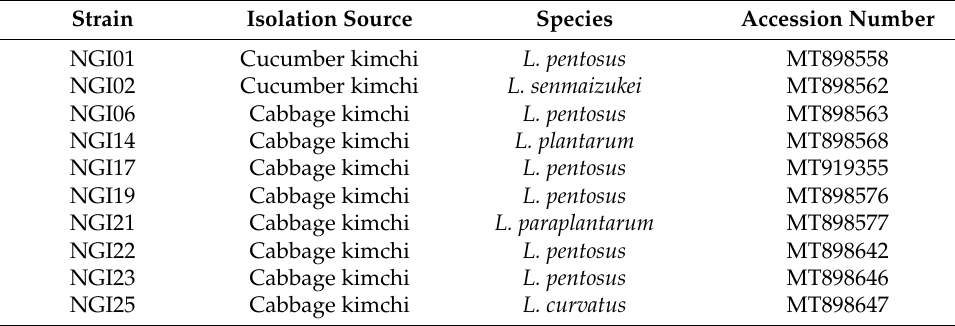
Table 1. Identification of LAB strains with high enzyme activities.